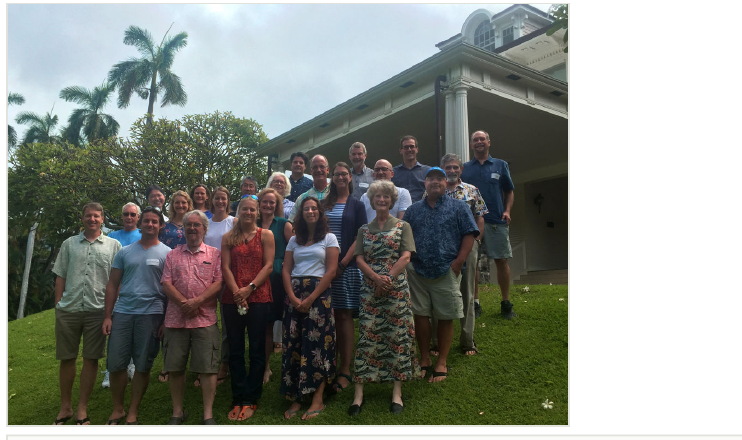
Figure 1. Front row left to right: Je ff Drazen, Pierre Dutrieux, Les Watling, Astrid Leitner, Emily Young, Verena Tunnicli ff e. Second row: Chris Measures, Mariko Hatta, Jessica Perelman, Erica Goetze, Jen Durden, Celine Taymans. Third row: Hiroyuki Yamamoto, Kristina Gjerde, Paul Hill, Amanda Ziegler, Chris Hauton, Tracey Sutton. Back row: Steve Haddock, Malcolm Clark, Tom Peacock, Tony Koslow, Craig Smith. Not Pictured: Whit Au, Jesse Black, Frank Parrish, Aude